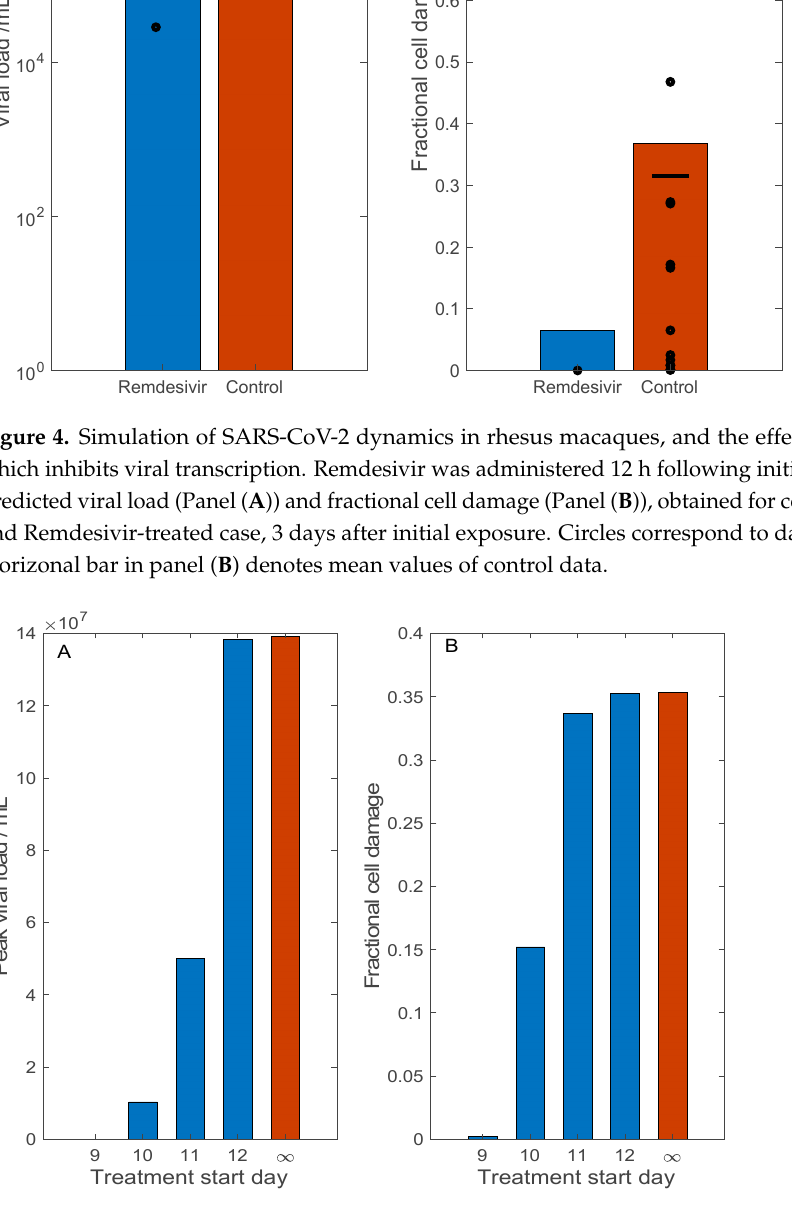
Figure 5. Effect of Remdesivir treatment on SARS-CoV-2 dynamics, and how that effect changes with treatment delay. Treatment may begin 9, 10, 11, or 12 days after initial viral exposure. Predicted maximum viral load (Panel ( A )) and fractional cell damage (Panel ( B )) are shown. Blue bar, with Remdesivir treatment; red bars, control (no treatment). Remdesivir offers significant protection only if administered no more than 10 days following exposure, or almost immediately after symptom